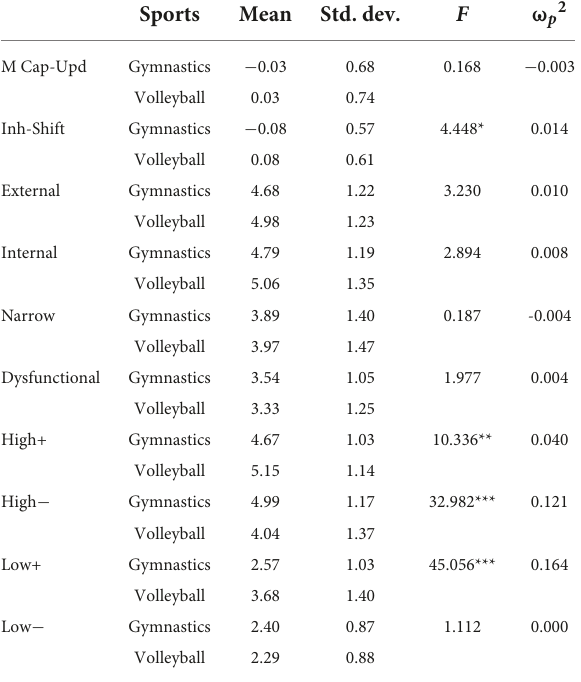
TABLE 10 Univariate comparisons between artistic gymnasts ( n = 104) and volleyball players ( n = 114) on all the predictors. Sports Mean Std.